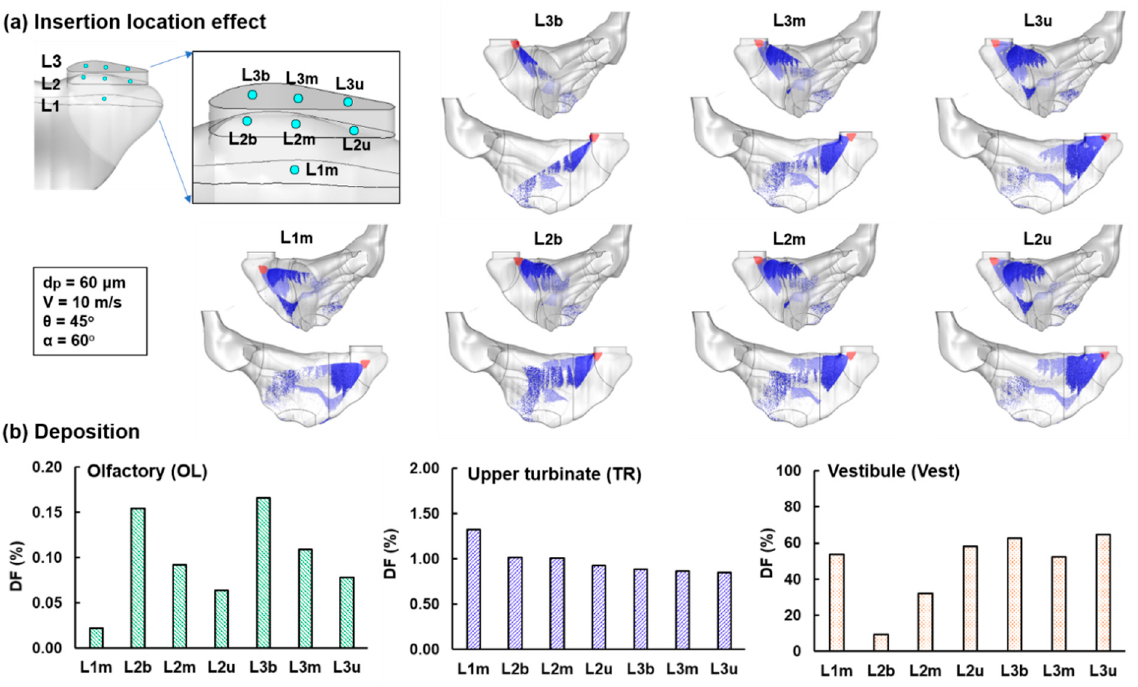
Figure 5. Spray release position effect: ( a ) spray deposition distributions (50% wall transparency) with seven release positions with three insertion depths and three points (tip, middle, base) on certain depths and ( b ) comparison of subregional DF in the olfactory (OL) region, upper turbinate (TR), and vestibule (Vest).